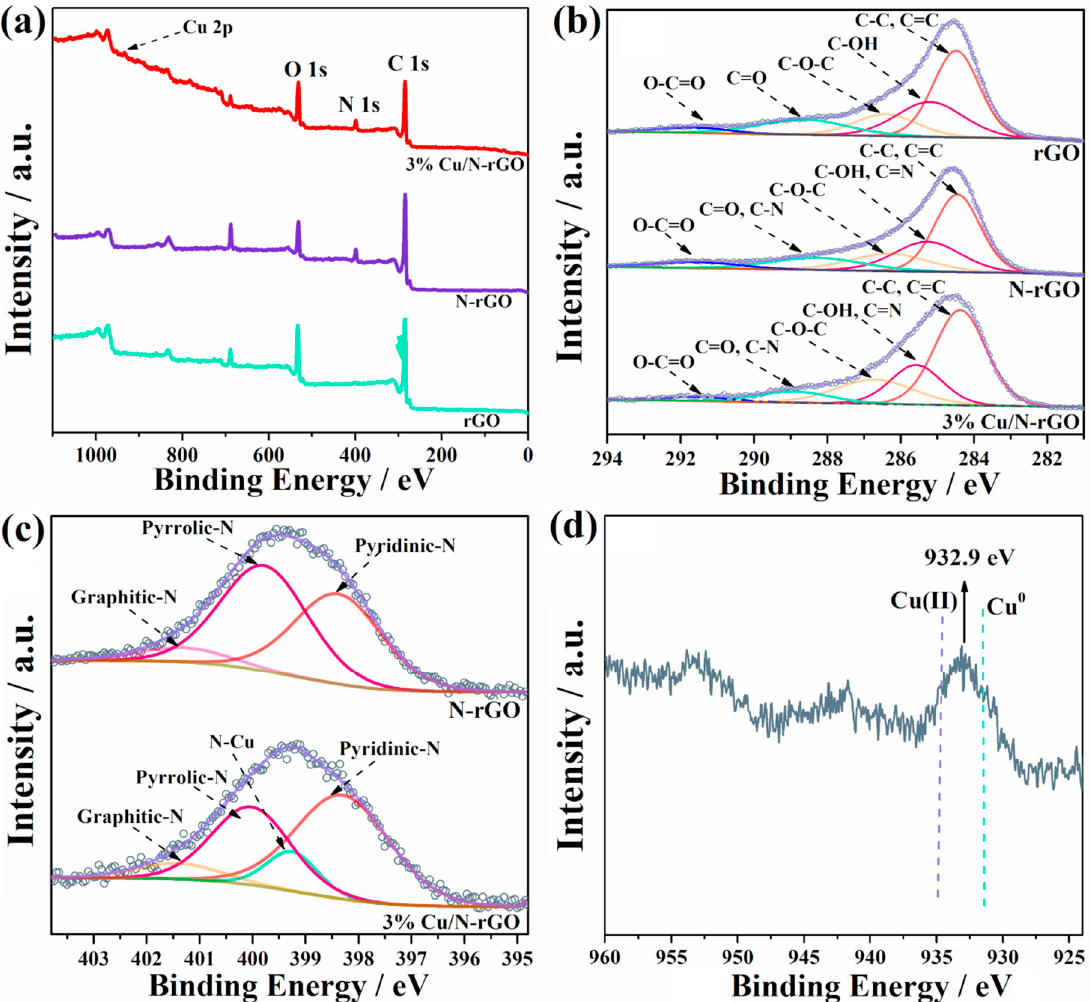
Figure 3. ( a ) Wide survey XPS spectra of rGO, N-rGO, and 3%Cu / N-rGO; ( b ) C 1s spectra of rGO, N-rGO and 3%Cu / N-rGO; ( c ) N 1s spectra of N-rGO and 3%Cu / N-rGO; ( d ) Cu 2p of 3%Cu / N-rGO.